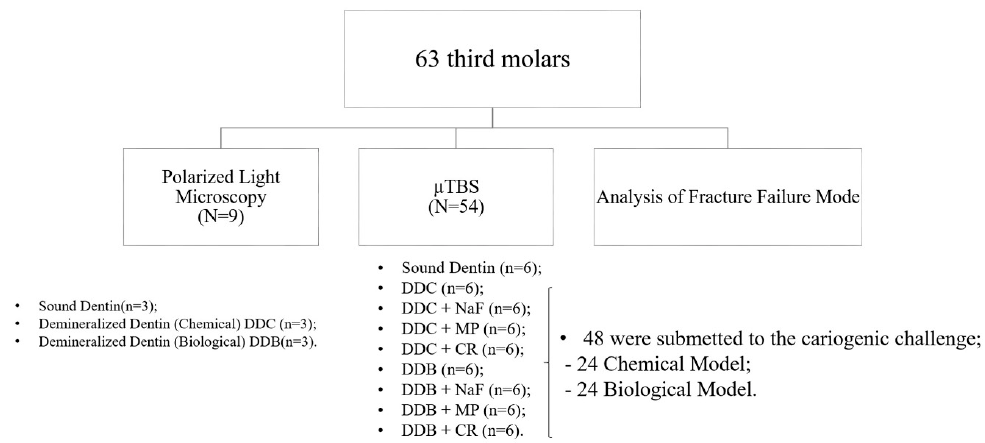
Figure 1. Experimental design. DDC—demineralized dentin provided by chemical model; DDC/NaF-